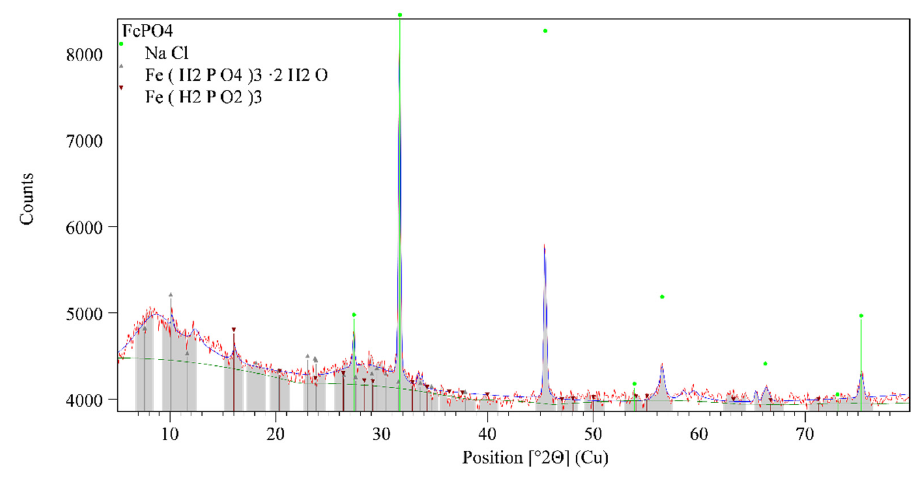
Figure 6. XRD pattern of ferric phosphate (FePO 4 ).